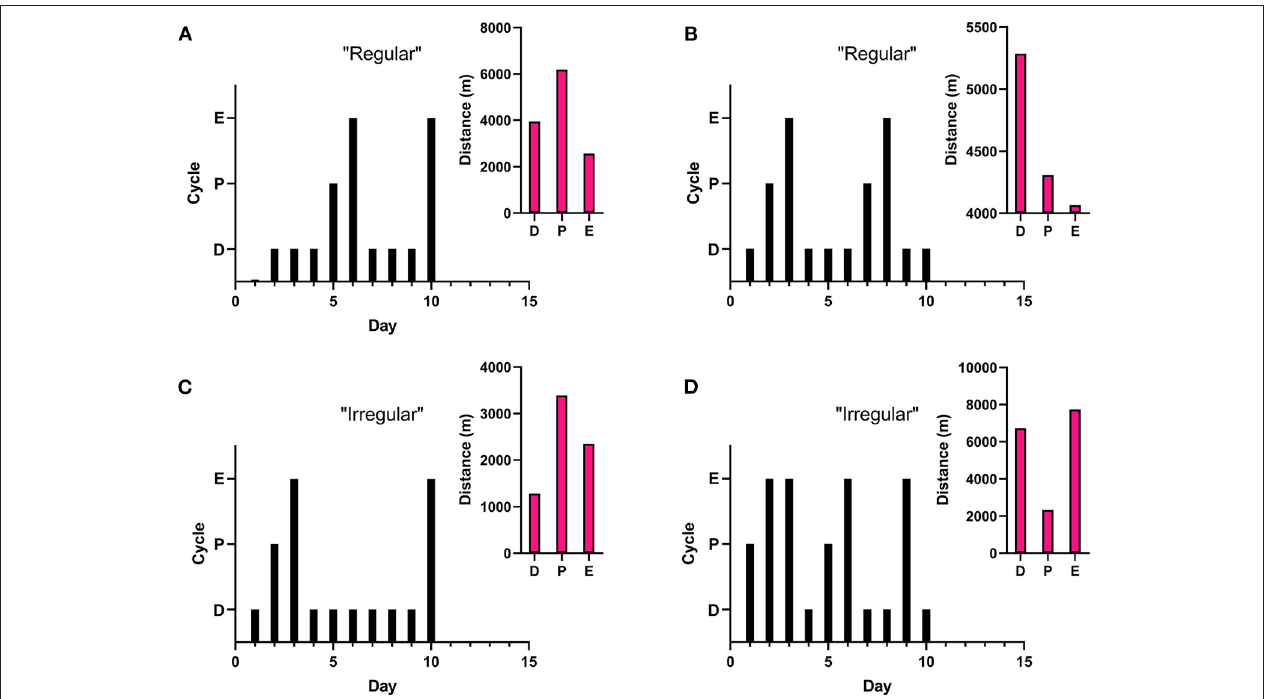
FIGURE 4 | Estrous Related Running. Stage in estrous cycling (Proestrus, Estrus, Diestrus) was monitored each day rats were in locked or functional wheels. A “regular” cycle is a typical 4–5 day cycle (estrus to estrus), while an “irregular” cycle can be either extended (3–4 consecutive days in estrus or 4–5 consecutive days in diestrus) or abnormal (cycle length < 3 days, > 4 days in estrus, or > 6 days in diestrus). Graphs represent cycling patterns of individual female rats. Black bar graphs represent cycling patterns of individual females with the lowest bars representing diestrus (“D”), the middle bars representing proestrus (“P”), and the tallest bars representing estrus (“E”). The pink insets show representative distance run of the same rat during different cycling stages. (A) Regular cycle with running distance correlating with estrous stage. (B) Regular cycle without correlation with estrous stage. (C) Irregular (extended) cycle with running distance correlating with estrous stage. (D) Irregular (abnormal) cycle without correlation with estrous